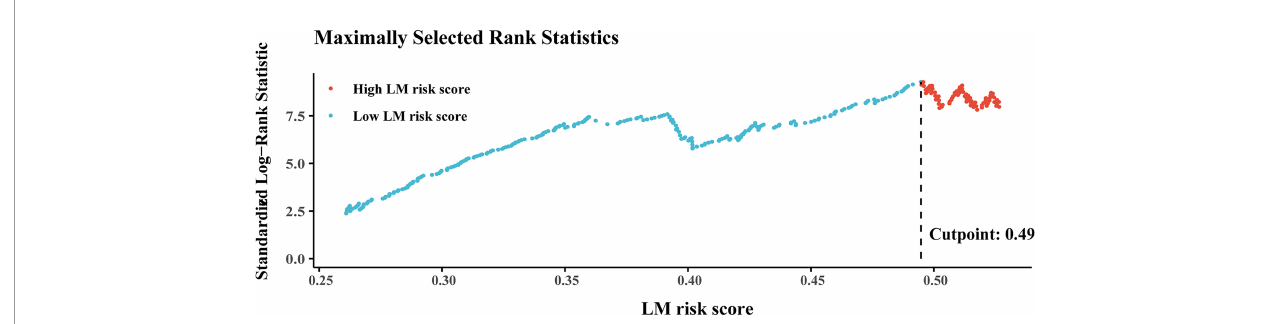
FIGURE 4 | Plots of the best cutoff value of the LM risk score in the training cohort using the Kaplan – Meier method. LM, liver metastasis.